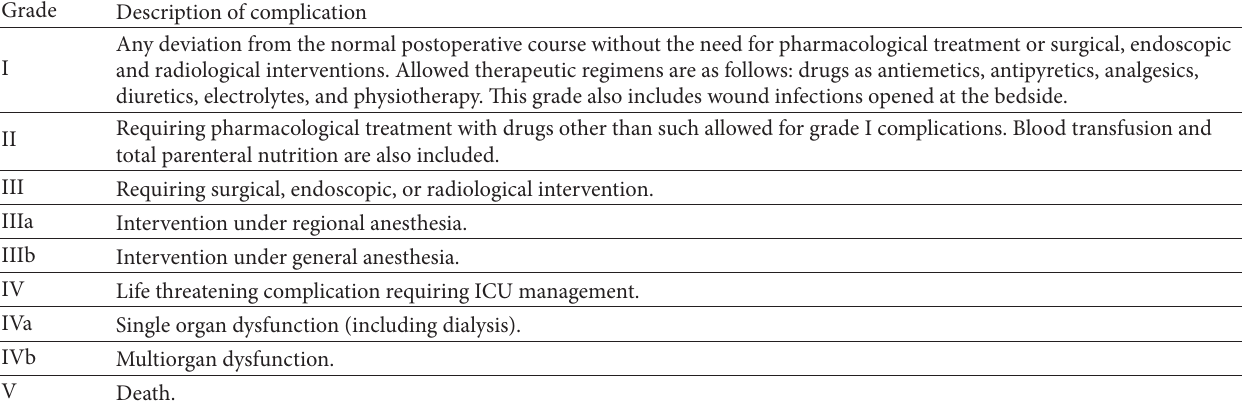
Table 1: Classification of surgical complications according to the modified Clavien grading system